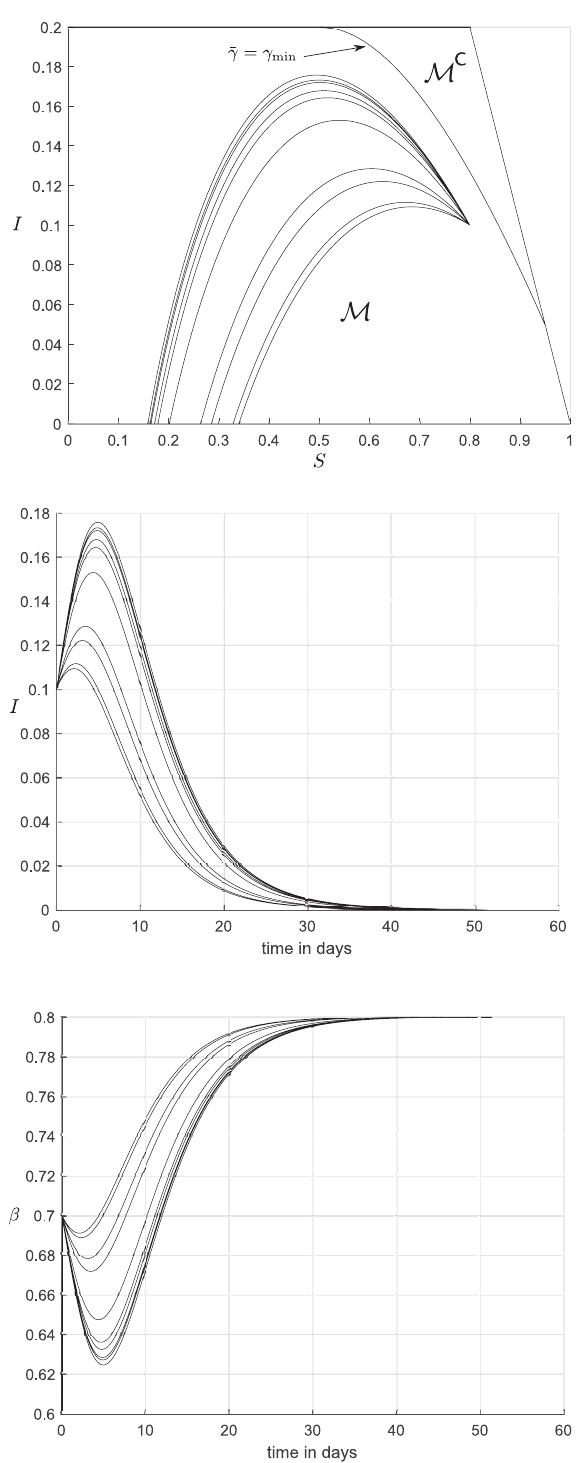
Fig 3. MRPI for imperfect SIR model example. We also show ten simulations from an initial state x randomly sampled γ 2 [0.3, 0.5].